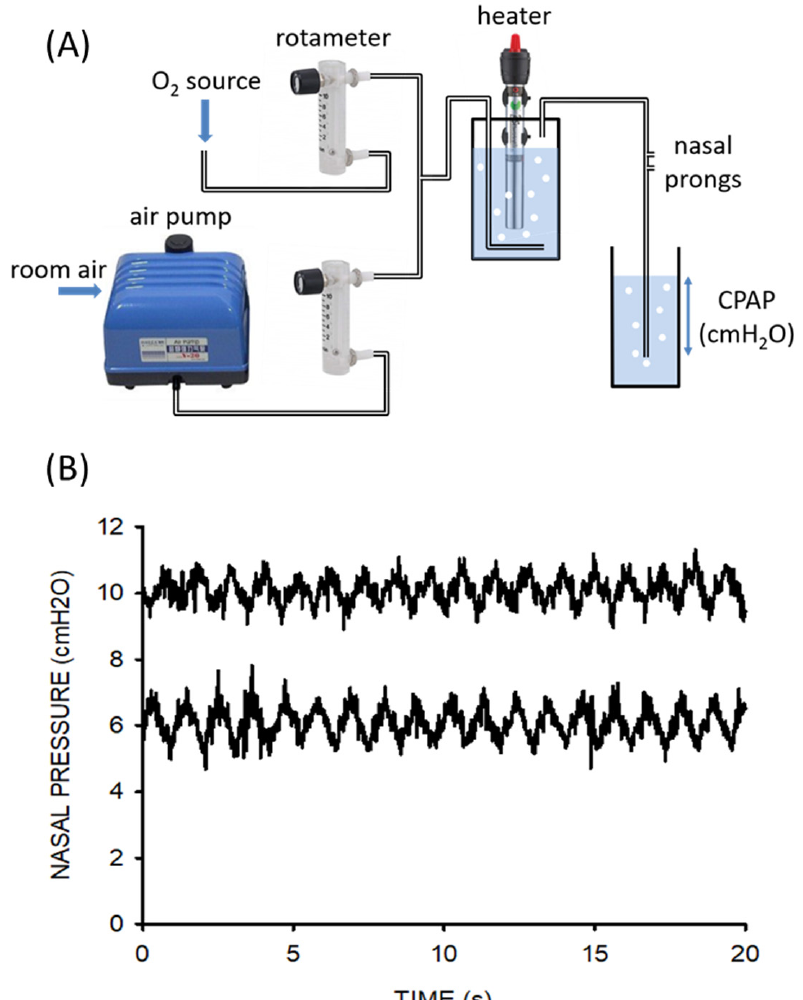
Figure 4. ( A ) Diagram of the CPAP setting, including its essential components: domestic aquarium air pump, rotameters, and domestic aquarium water heater/controller. ( B ) Nasal pressures actually applied at nasal prongs by the novel device for CPAP settings of 6 and 10 cm H 2 O. The simulated newborn infant was breathing with a tidal volume of 20 mL and frequency of 55 breaths/min while 8 L/min of humidified heated airflow circulated through the circuit. Reprinted with permission from Ref. [62]. Copyright by the American Thoracic Society.